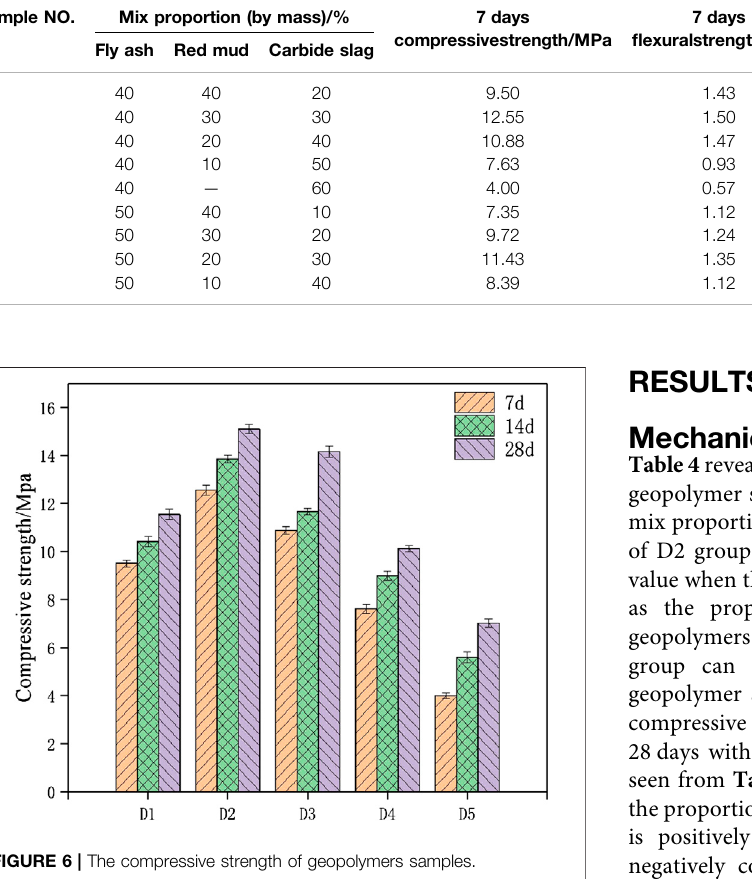
FIGURE 6 | The compressive strength of geopolymers